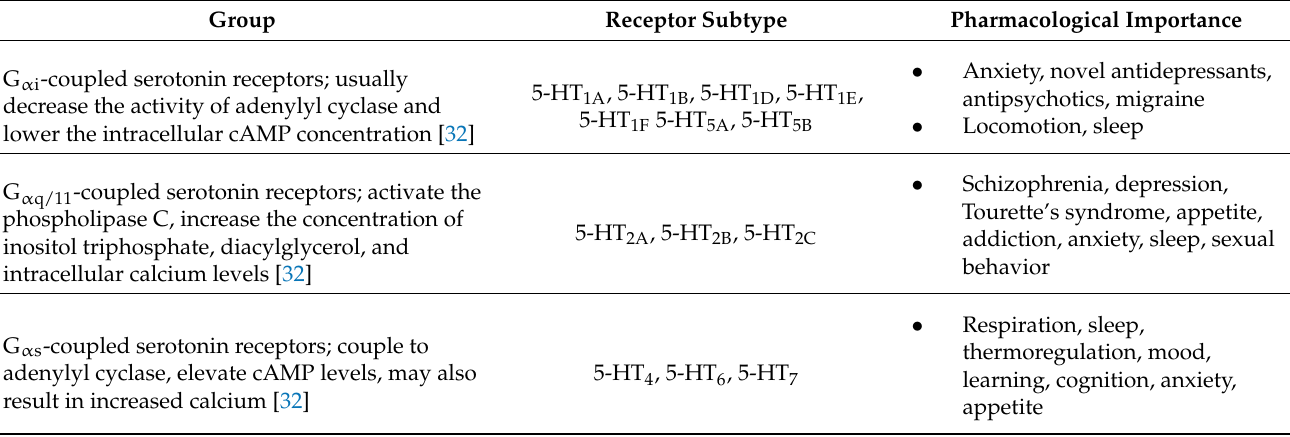
Table 1. Classification of 5-HT receptors according to the affected signaling pathways and pharmaco- logical